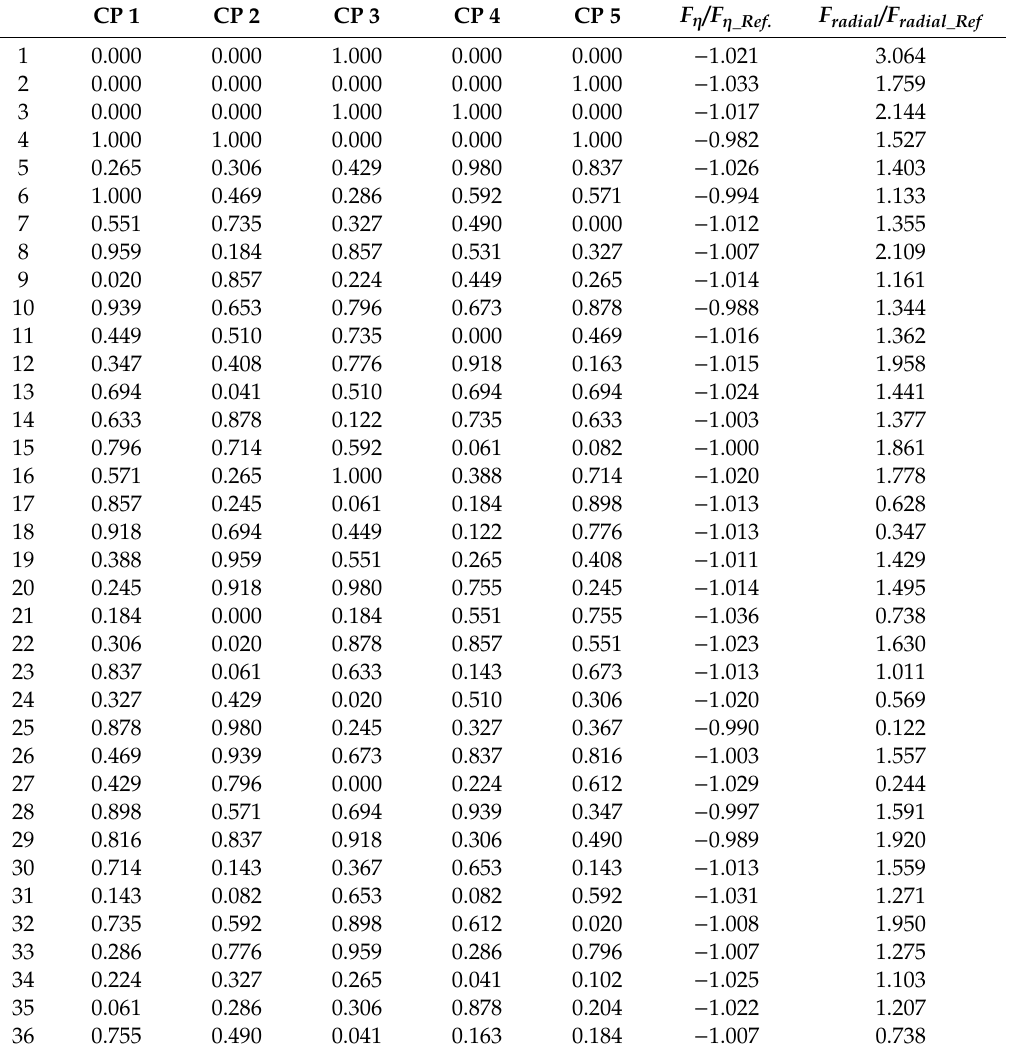
Table A1. Design variables and objective functions values at LHS design